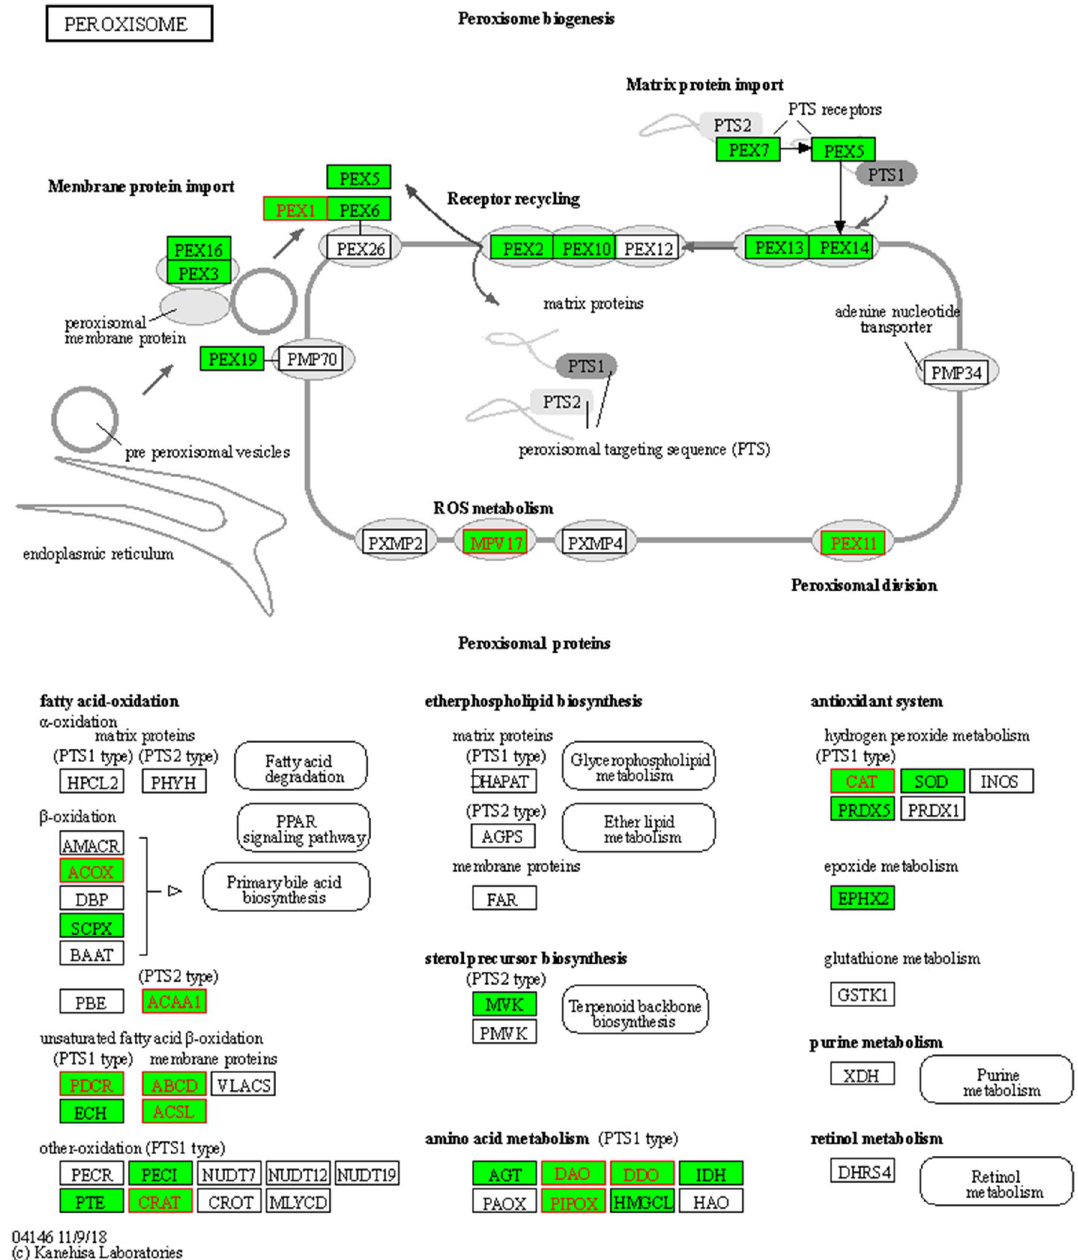
Figure 8. The peroxisome pathway, which might be involved in the up-regulation of genes in stage D relative to stage M of fruiting body development in C.